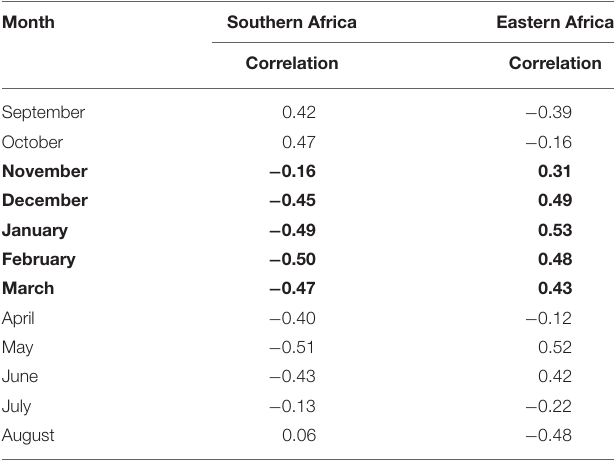
TABLE 1 | Monthly correlation coefficients between ENSO and standardized NDVI anomalies during the study period of 2010–2019 in Eastern and Southern